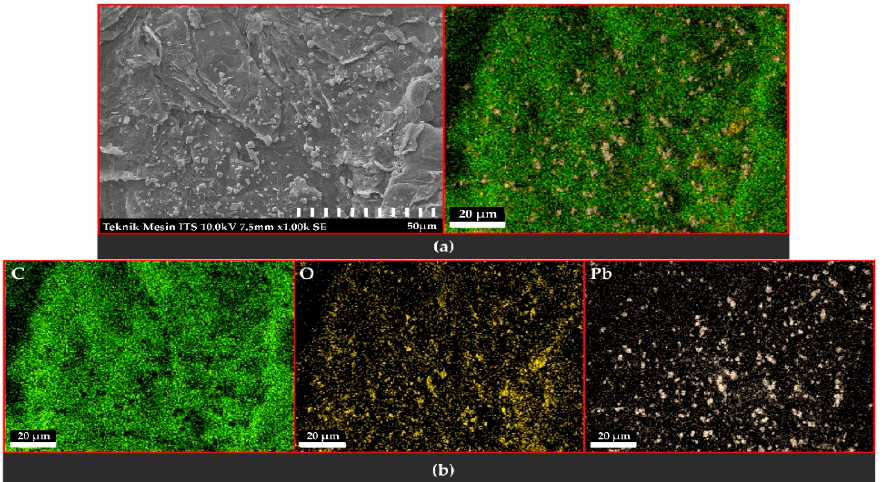
Figure 6. ( a ) Multi-element element energy-dispersive X-ray spectroscopy mapping image. ( b ) Digital mapping image of elements C, O, and Pb at 9 V.